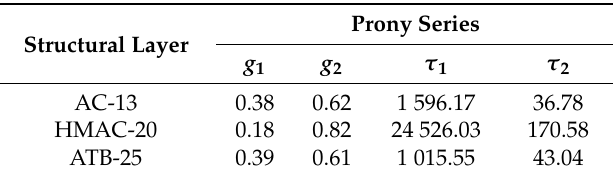
Table 5. Prony parameters in the Burgers